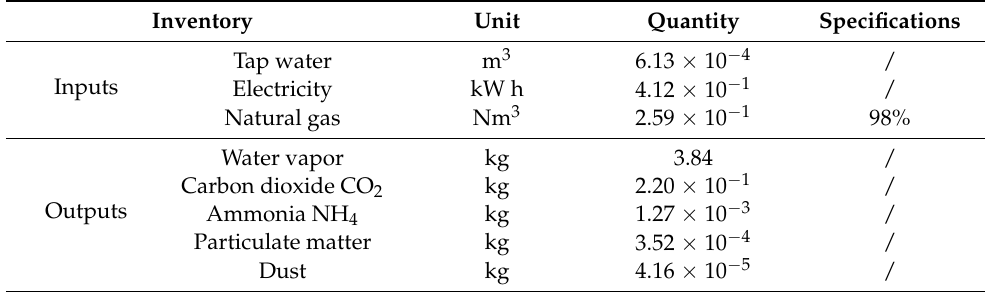
Table 3. Life cycle inventory data for the oxidation scorching